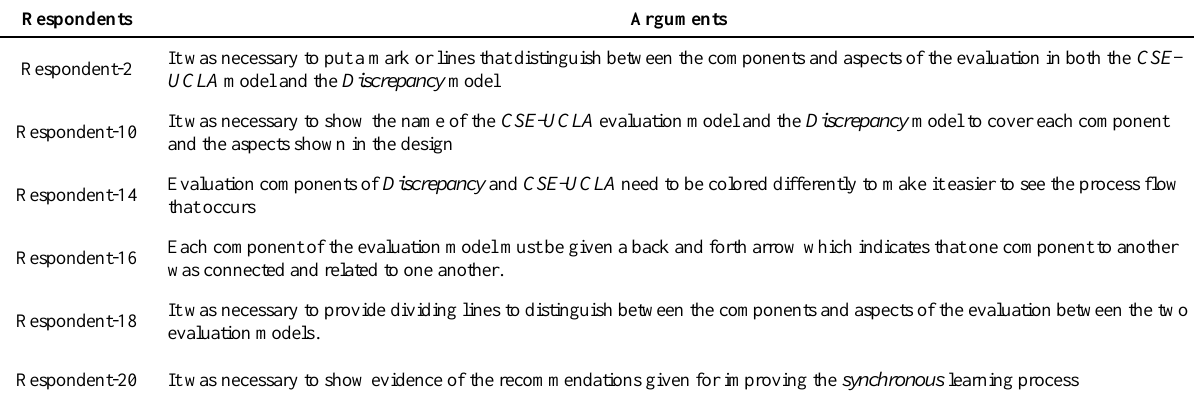
Table 5. Respondents’ Arguments toward the Design of CSE-UCLA Model that Modification with Discrepancy